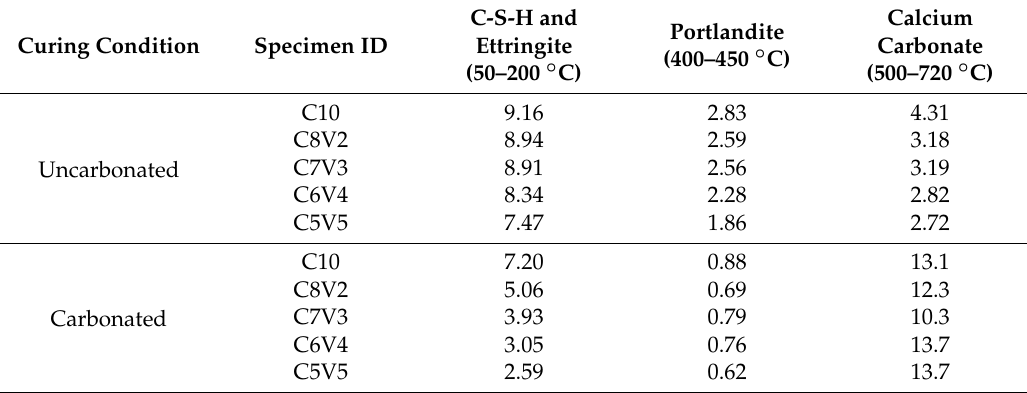
Table 4. Relative weight loss (%) attributed to the decomposition of reaction products at 28 days.